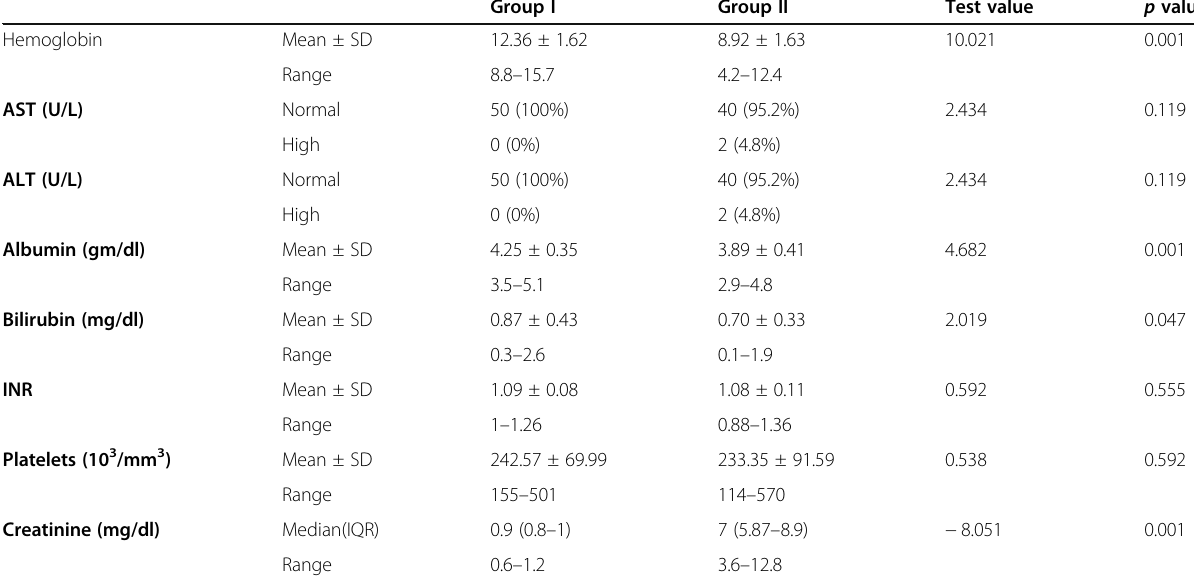
Table 6 Comparison between group I (control group) and group II (case group) regarding levels of hemoglobin, AST, ALT, albumin, total bilirubin, INR, platelets, and creatinine 12 weeks after